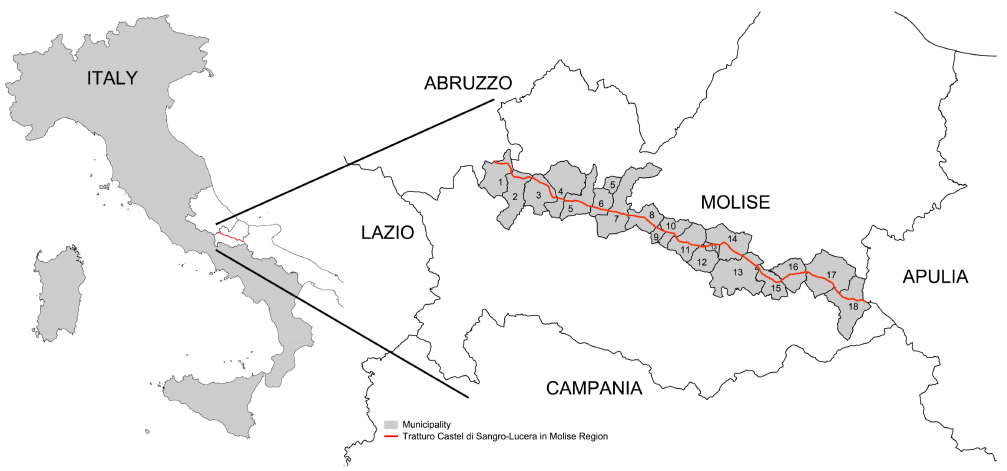
Figure 2. Tratturo Castel di Sangro-Lucera geographical extension in Molise Region. Numbering of the municipalities along the tratturo: (1) Rionero Sannitico, (2) Forl ì del Sannio, (3) Roccasicura, (4) Carovilli, (5) Pescolanciano, (6) Chiauci, (7) Civitanova del Sannio, (8) Duronia, (9) Molise, (10) Torella del Sannio, (11) Castropignano, (12) Oratino, (13) Campobasso, (14) Ripalimosani, (15) Campodipietra, (16) Toro, (17) Pietracatella, (18)